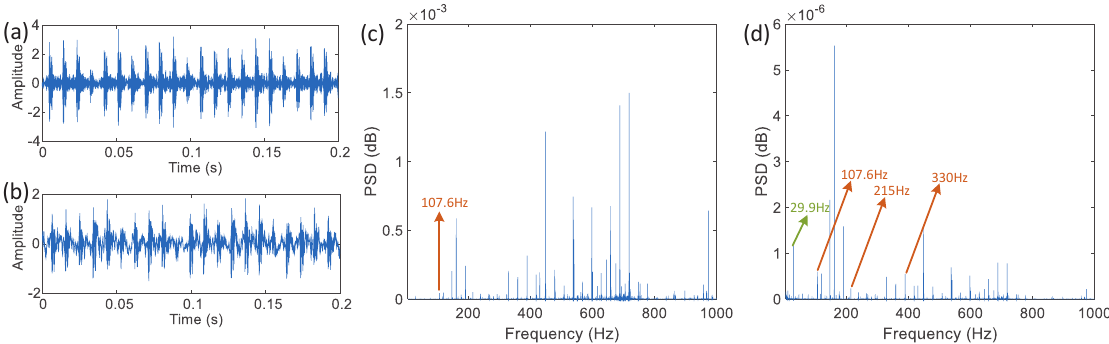
Figure 9. The vibration signal ( a ), the synchronous error ( b ), the power spectral density of outer ring damage using the measured signal ( c ) and the synchronization error ( d